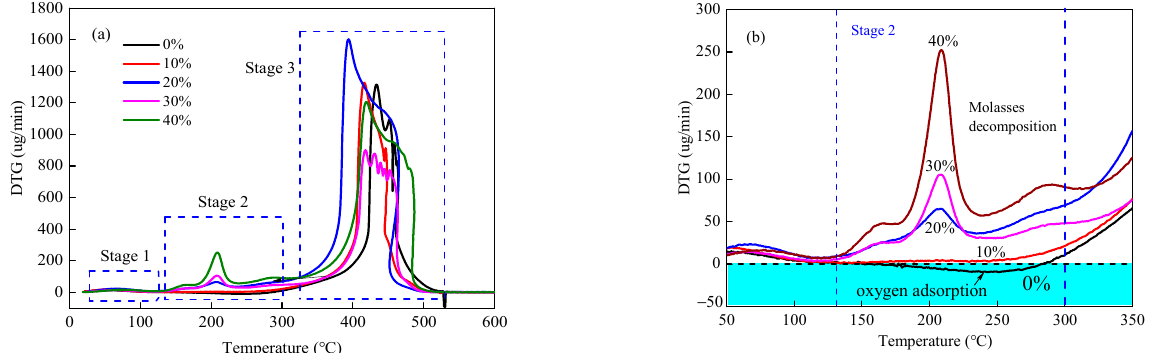
Figure 9. The DTG curve of the coal dust mixed with molasses at 0–600 ° C ( a ) and 0–300 ° C ( b ).